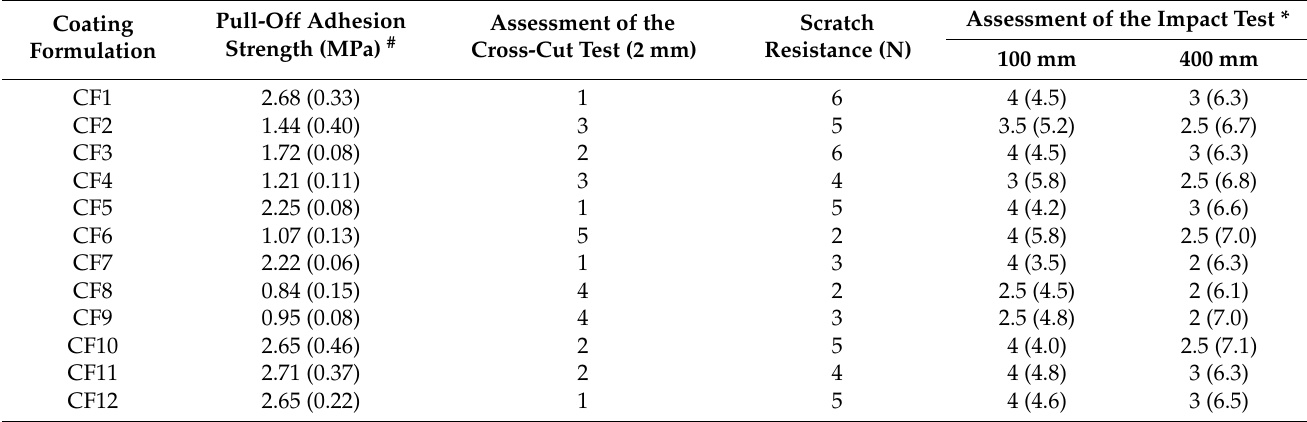
# Standard deviation in the parentheses. * 100 and 400 mm is the drop height and values in parentheses the diameter of Table 2. Adhesion strength, scratch resistance, and impact resistance of the coating formulations after two weeks of curing the crater caused by the impact. under ambient conditions (23 ± 3 ◦ C and (50 ± 5)% relative humidity). Coating Formulation